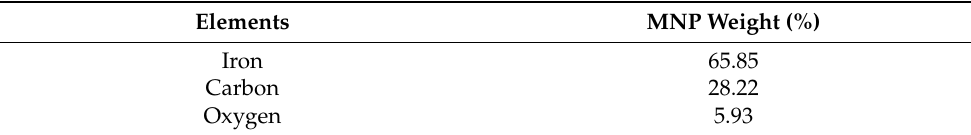
Table 3. Elemental compositions of